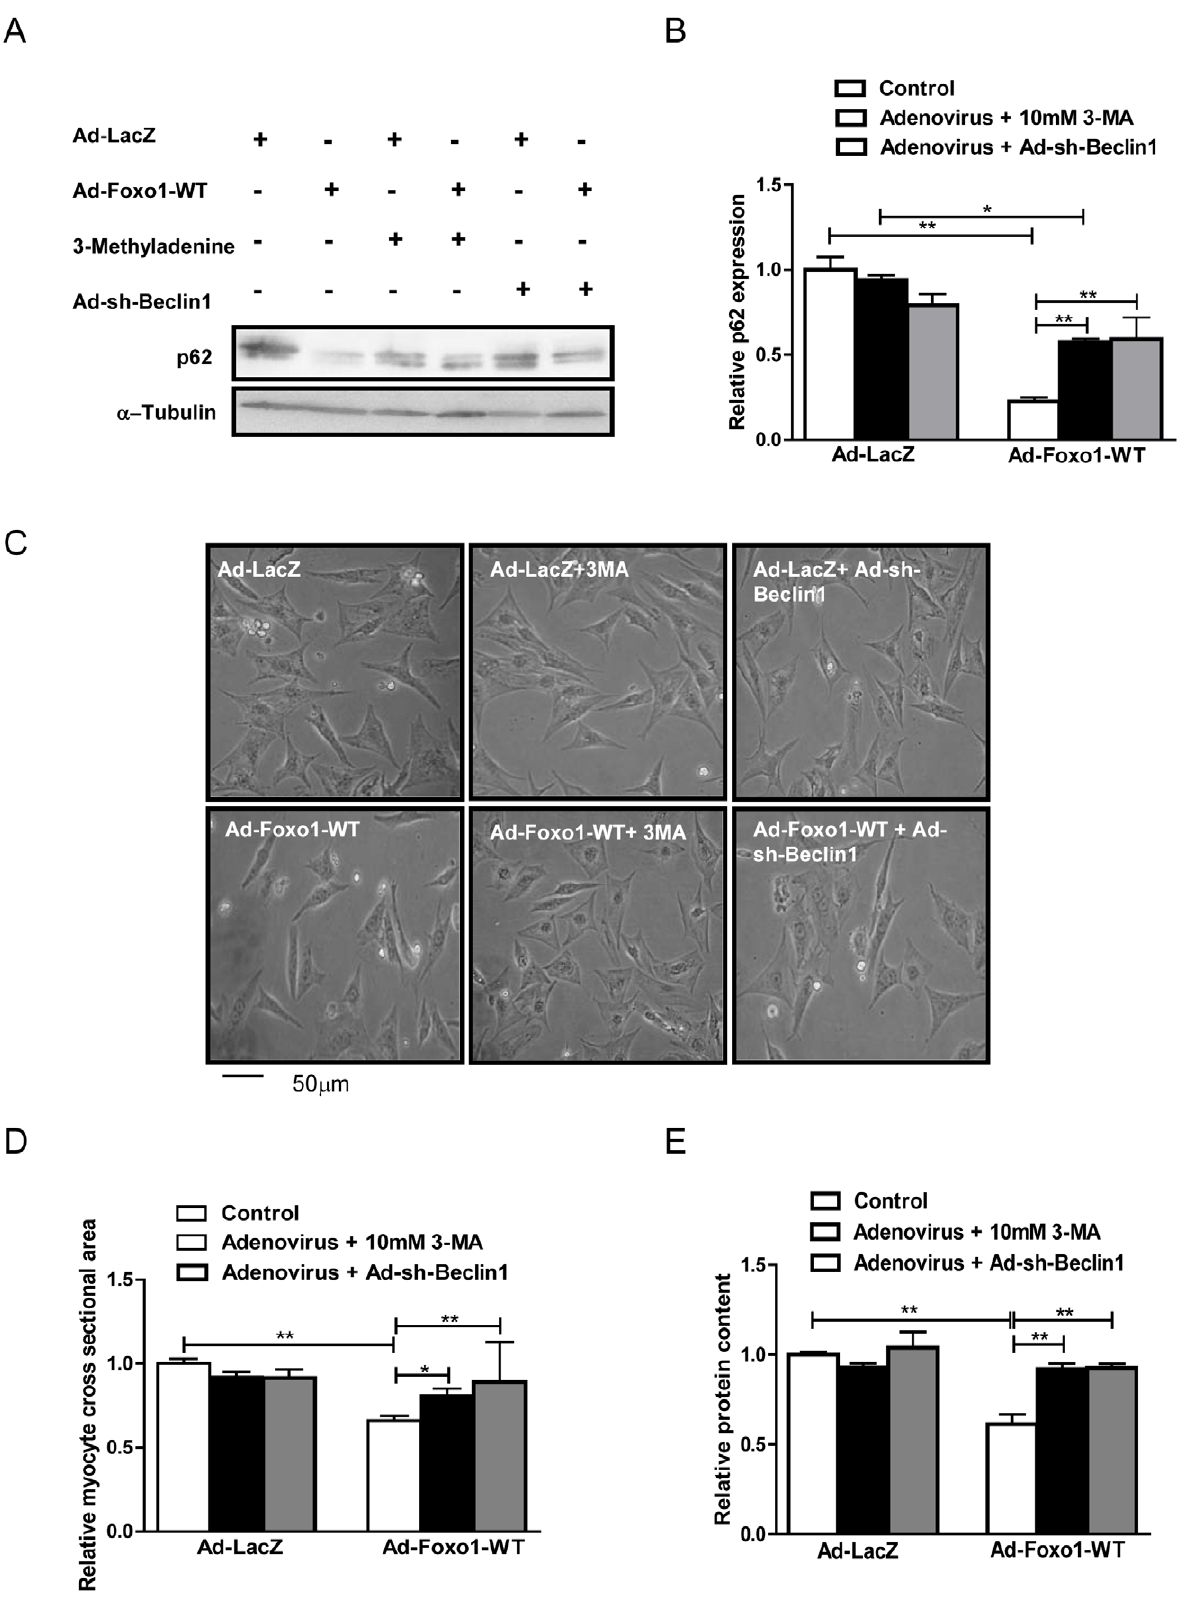
Figure 4. Autophagy inhibition attenuates FoxO1-induced reduction in cell size and relative protein content. Cultured cardiomyocytes were transduced with Ad-FoxO1-WT or Ad-LacZ for 24 hours or Ad-sh-Beclin1 for 96 hours, and treated with 10 mM 3-methyladenine (3-MA) for 24 hours. A) Representative immunoblots. B) Densitometric analyses. C) Representative images of cardiomyocytes viewed under a light microscope.